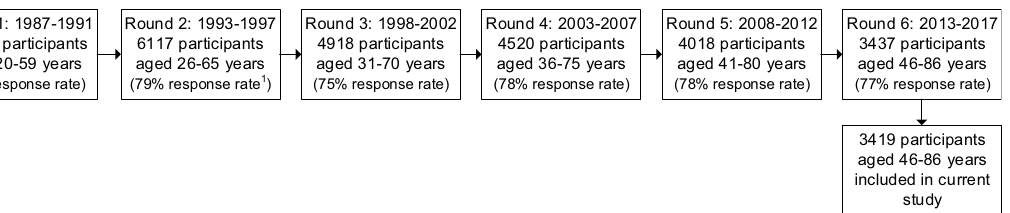
Figure 1. Flowchart of study participants. 1 Roughly two-third of the participants from round 1 were randomly selected and re-invited to participate in round